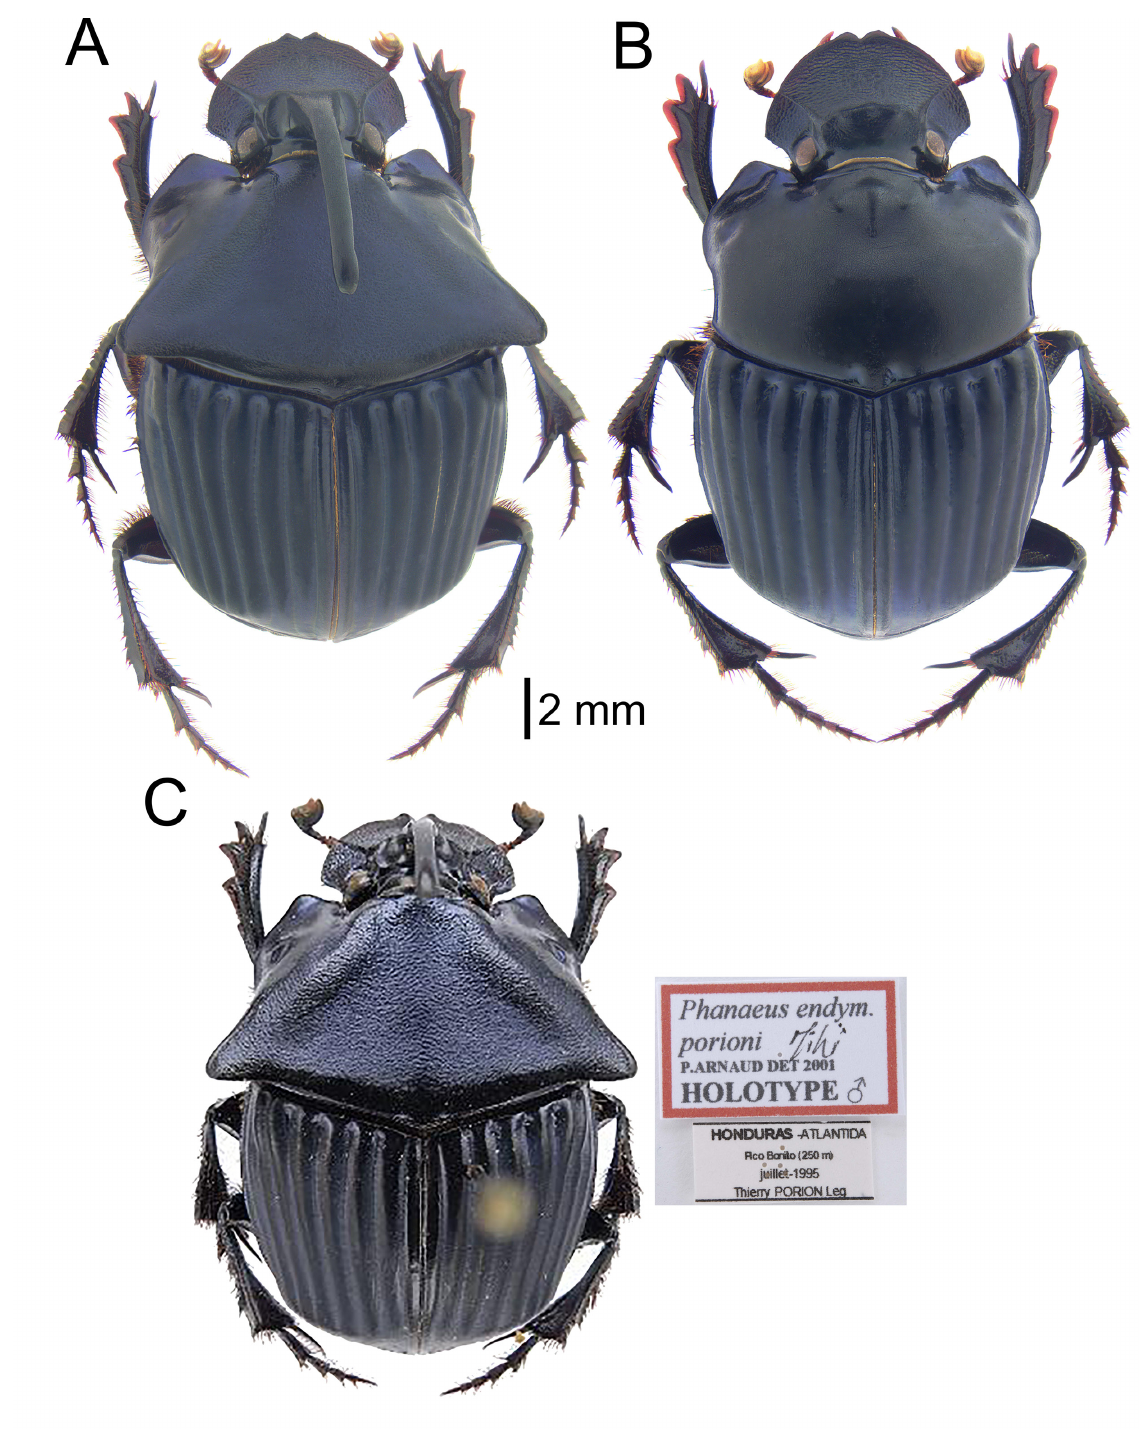
Fig. 11. Phanaeus porioni Arnaud, 2001 stat. rev. A . ♂ (TAMU). B . ♀ (TAMU). C . Holotype, ♂ (by Patrick Arnaud)